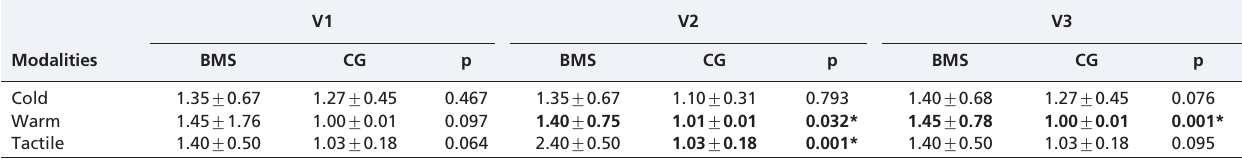
Table 2 - Between-group comparison of superficial sensibility in all modalities (cold, warm, and tactile) given the three trigeminal branches. Thresholds for the warm (V2 and V3) and tactile (V2) modalities were higher (N = 50).